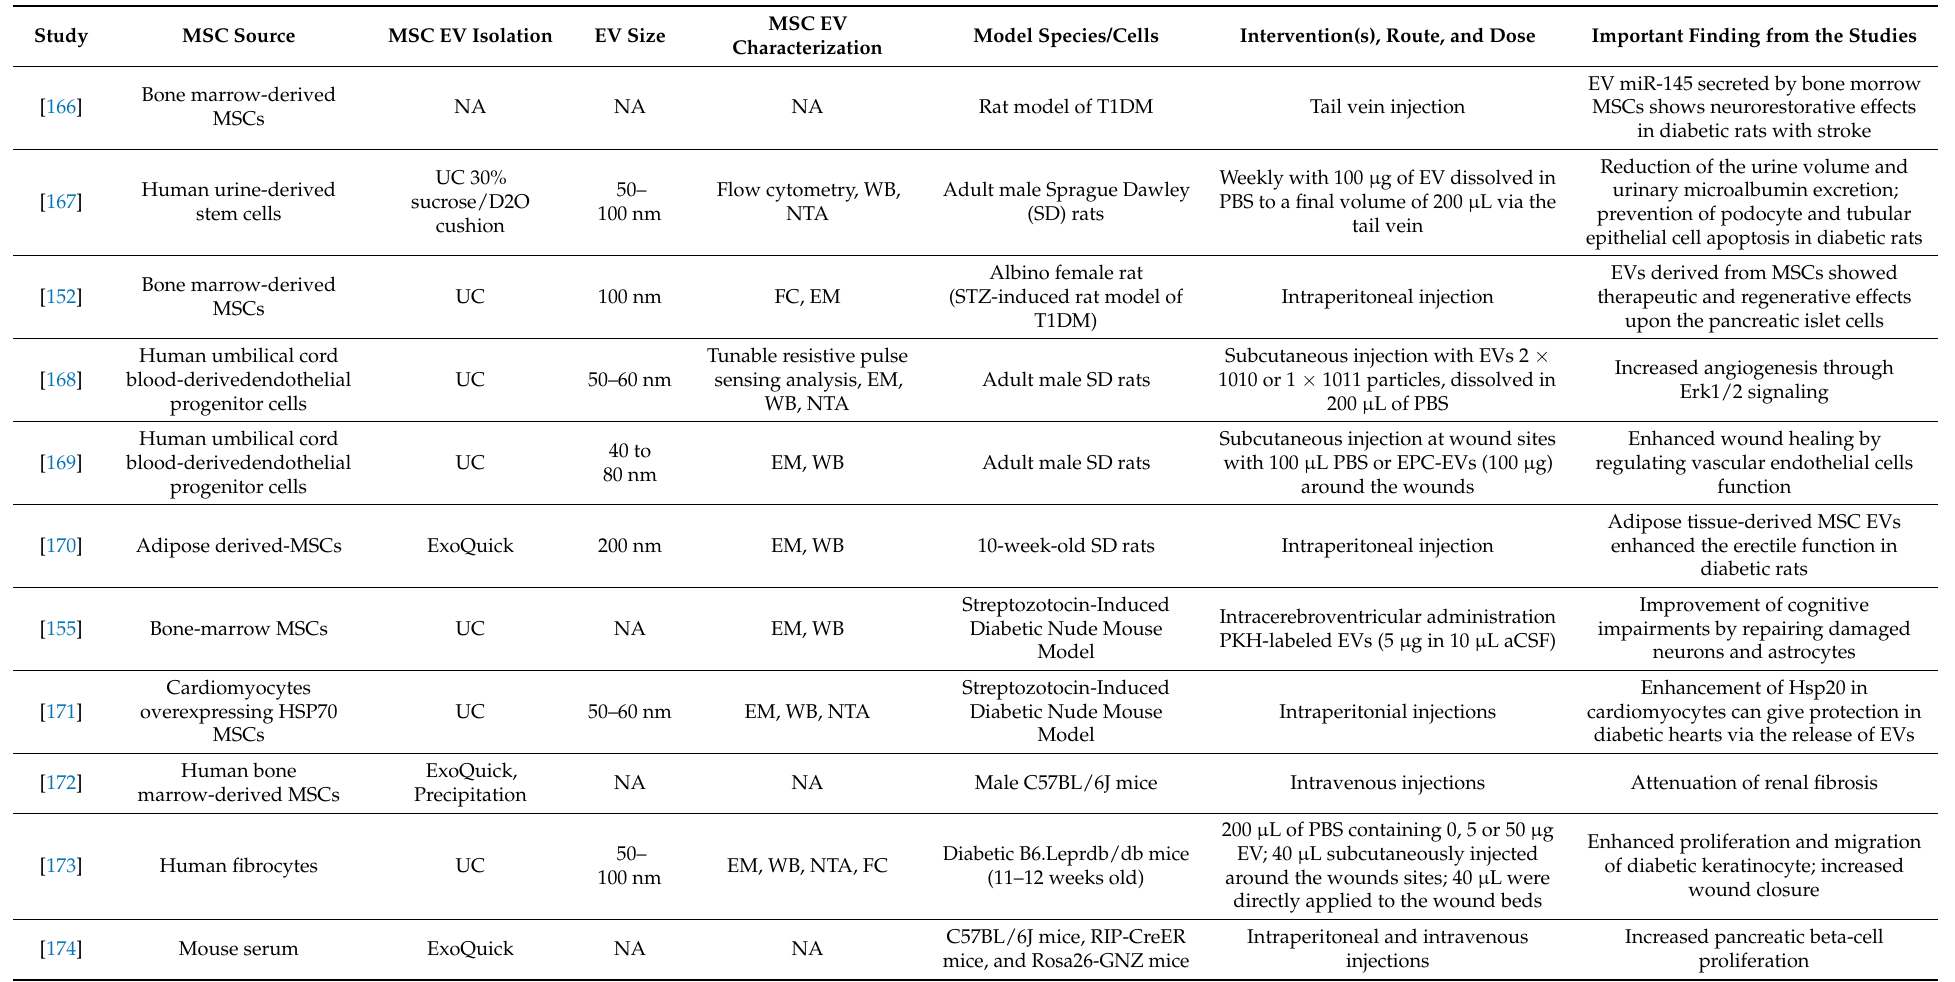
Table 5. EVs as therapeutics in